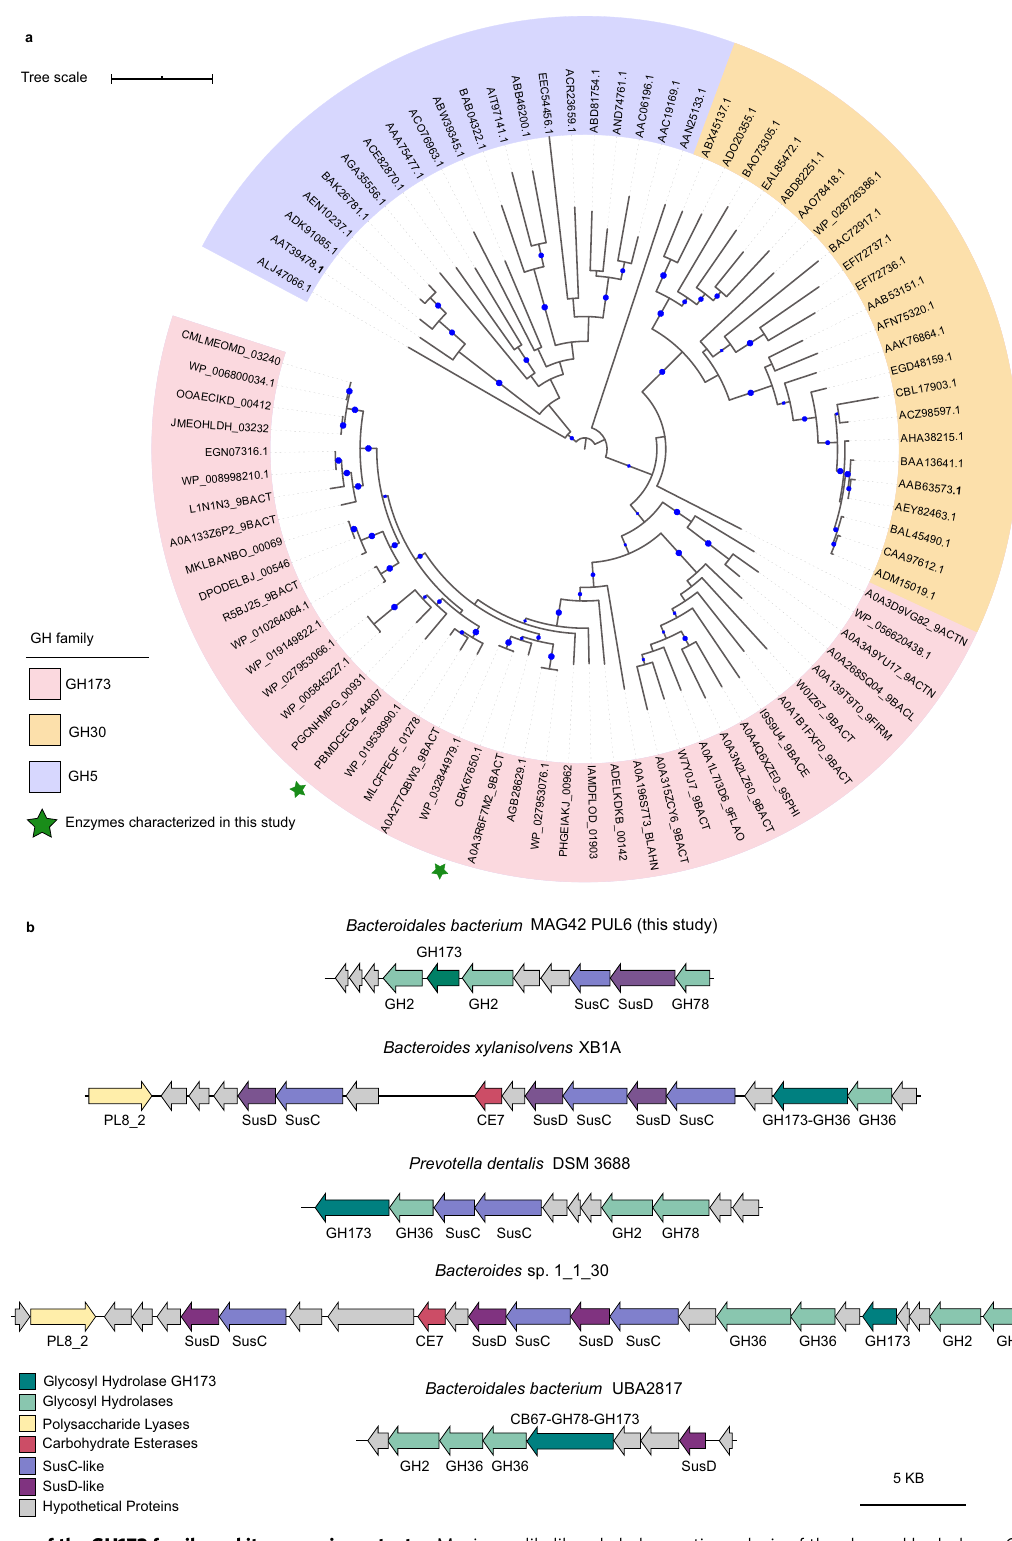
Fig. 6 Phylogeny of the GH173 family and its genomic context. a Maximum likelihood phylogenetic analysis of the glycosyl hydrolases GH173 family (pink background) including characterized members from the families GH30 (orange background) and GH5 (purple background). Nodes with bootstrap support values >50 are indicated by the blue circles. Founding members of GH173 family characterized in this study are denoted with a green star CapGH173 (PBMDCECB_44807) and BXY_26070 (CBK67650.1). b Genomic context of GH173-containing polysaccharide utilization loci (PULs) identi fi ed in Bacteroidetes metagenome - assembled genomes (MAGs).